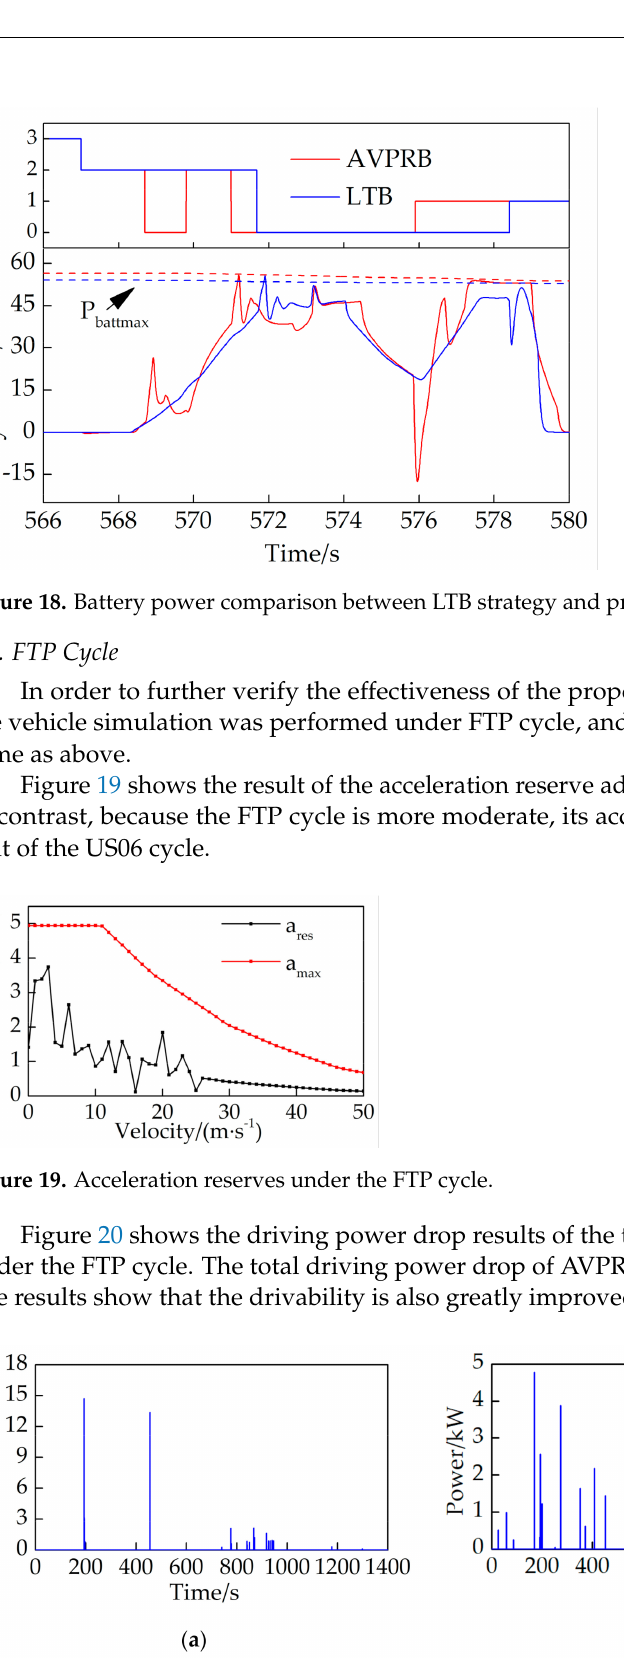
Figure 20. Driving power drop results under FTP cycle: ( a ) LTB strategy; ( b ) AVPRB